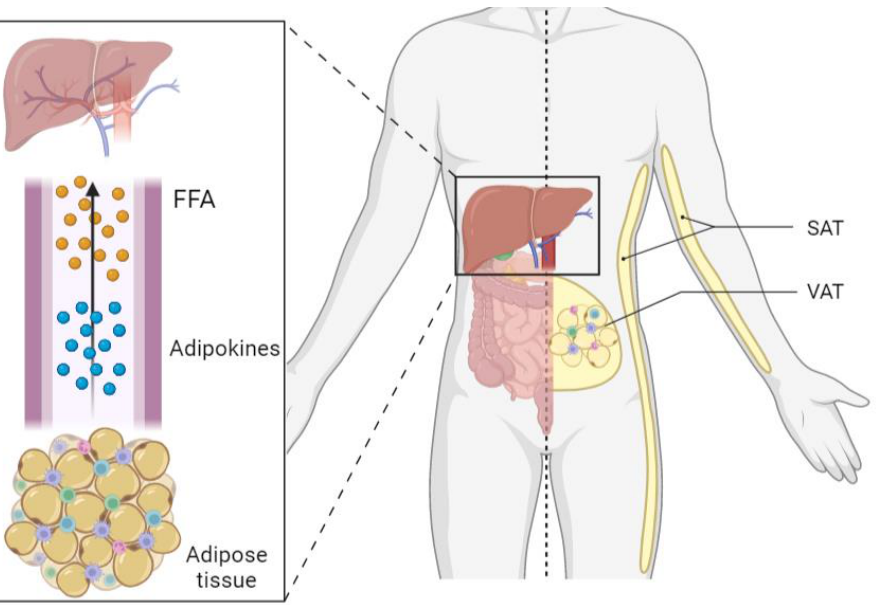
Figure 1. Crosstalk between adipose tissue and liver. Dysfunctional adipose tissue sends FFA and adipokines through the circulation to the liver, being implicated in nonalcoholic fatty liver disease. SAT, subcutaneous adipose tissue; FFA, free fatty acids; VAT, visceral adipose